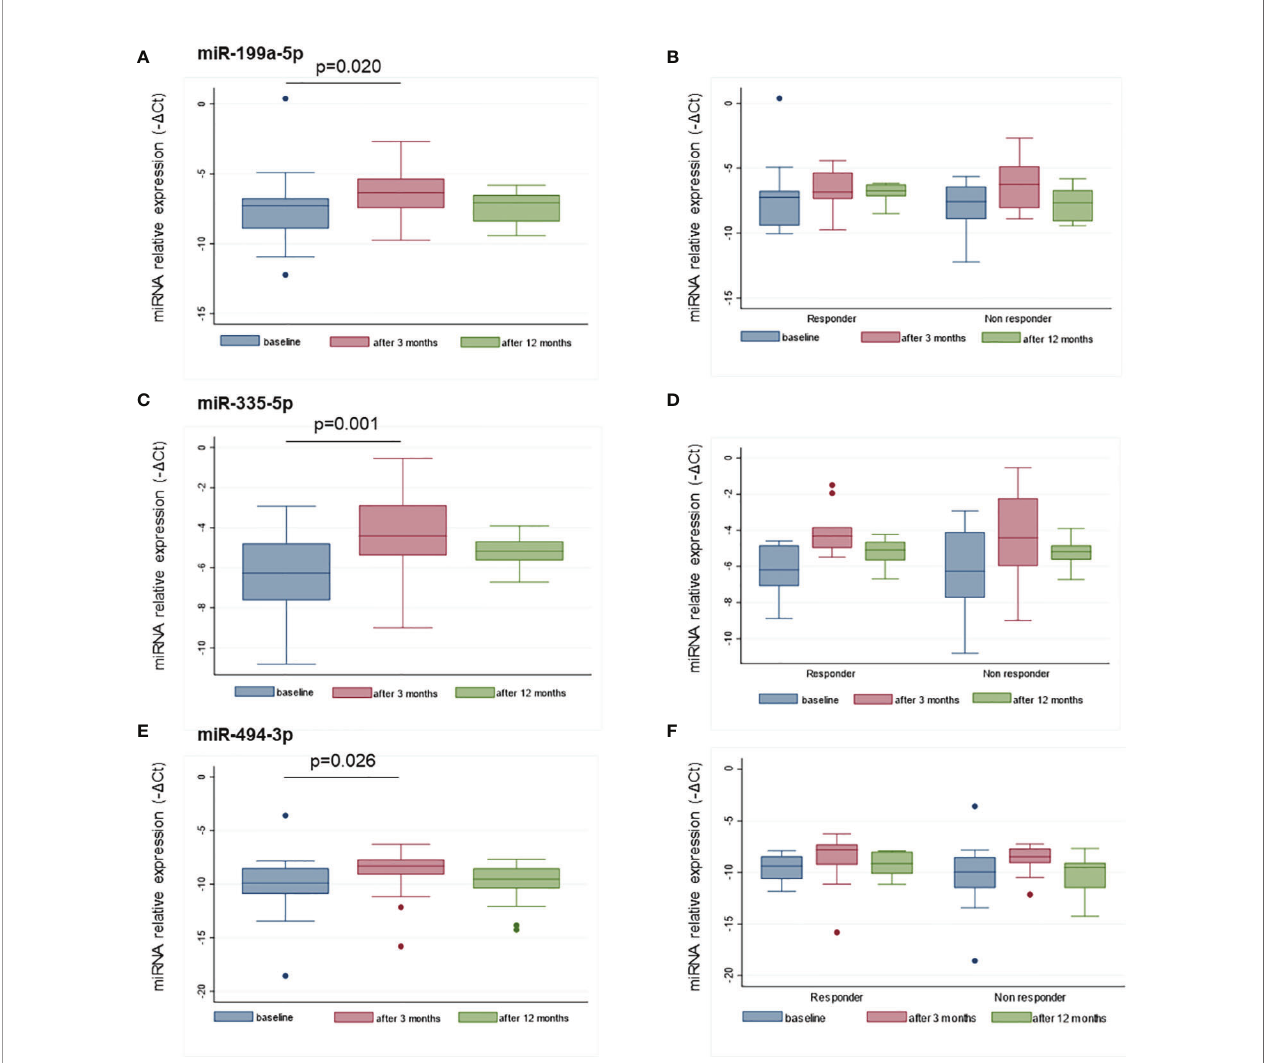
FIGURE 5 | Distributions of miR-199a-5p (A) , miR-335-5p (C) , and miR-494-3p (E) at baseline, and after 3 and 12 months of treatment. The distribution of the same miRNAs in responders and non-responders to GH treatment are reported at the same time points in panels (B, D, F) . MiRNA levels are expressed as – D Ct where D Ct is calculated as: Ct miRNA − Ct miR-16-5p. p -value ≤ 0.05 at paired Student ’ s t